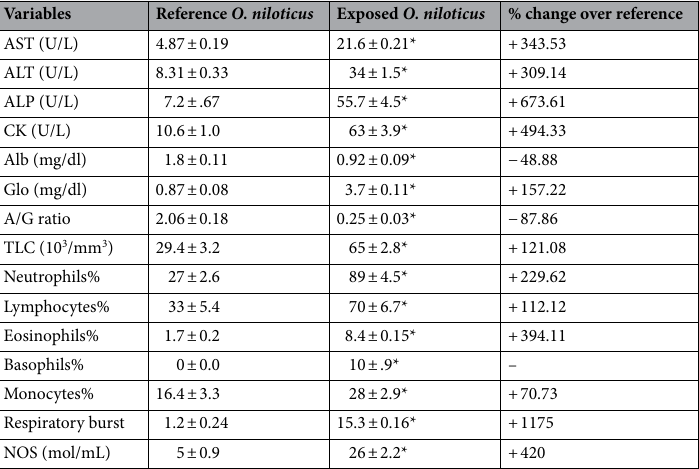
Table 3. Pathological marker enzymes and immune parameters in serum/blood. All values are given as mean ± SEM (n = 15); t-test was used for statistical analysis; Asterisk indicates significant difference at p < 0.05; + or – indicates increase or decrease over